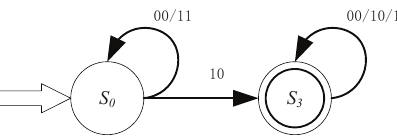
Figure 4. A Deterministic Finite Automaton for r p ⊃ r q .